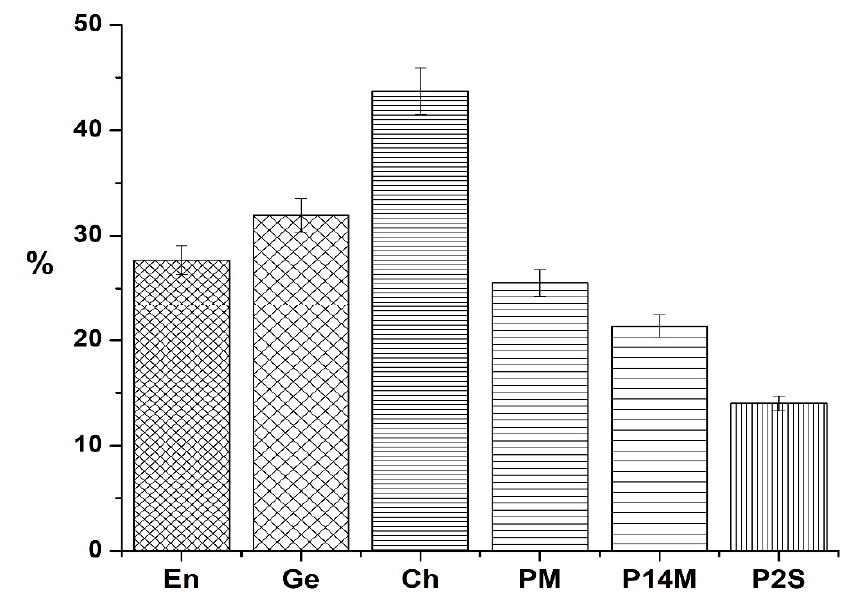
Figure 2. The residual double bonds (RDB) of resin composite discs (En = Enamel Plus HRV; G-ænial Anterior = Ge; Charisma = Ch; PM, P2S, P14M = experimental resin composites).